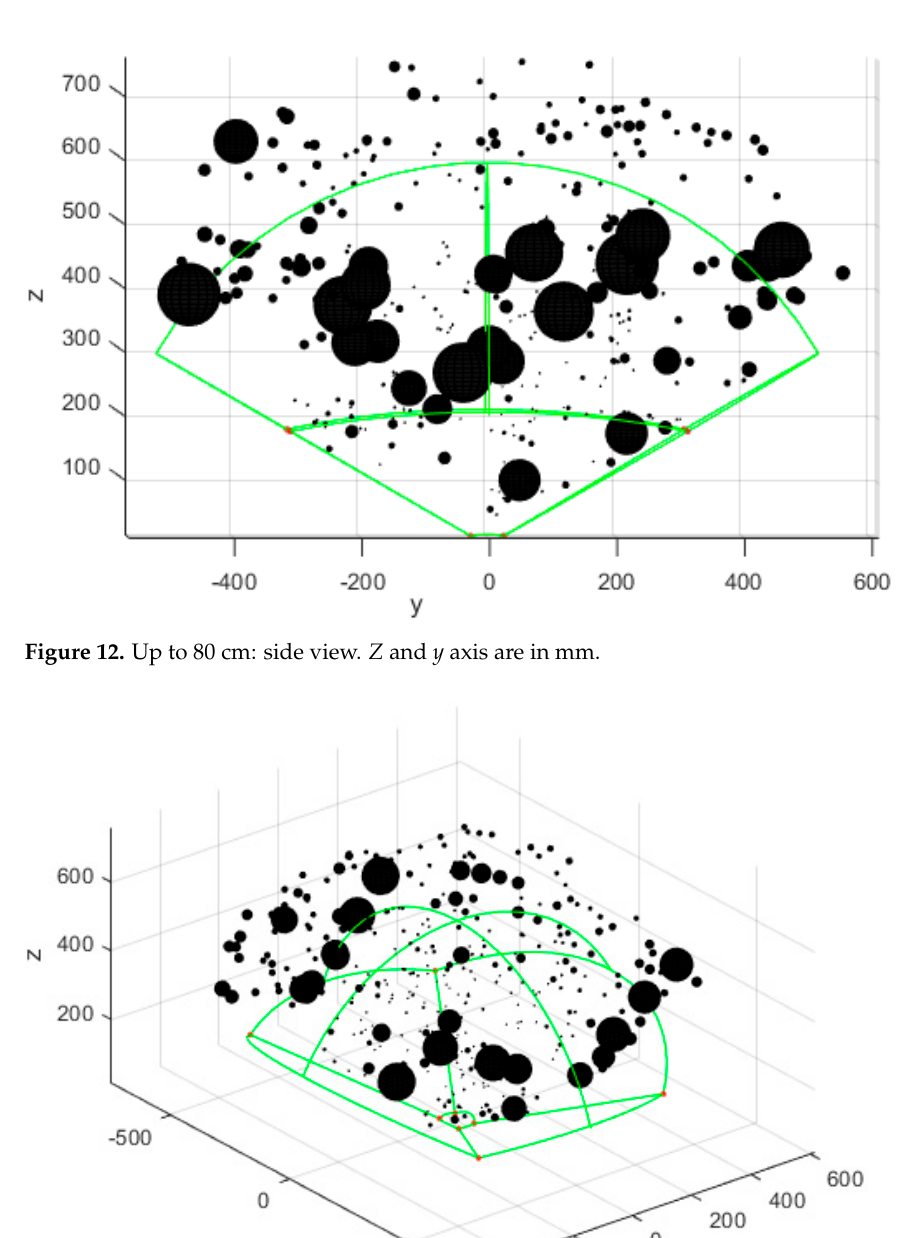
Figure 11. Up to 80 cm: front–back view. X and z axis are in mm.